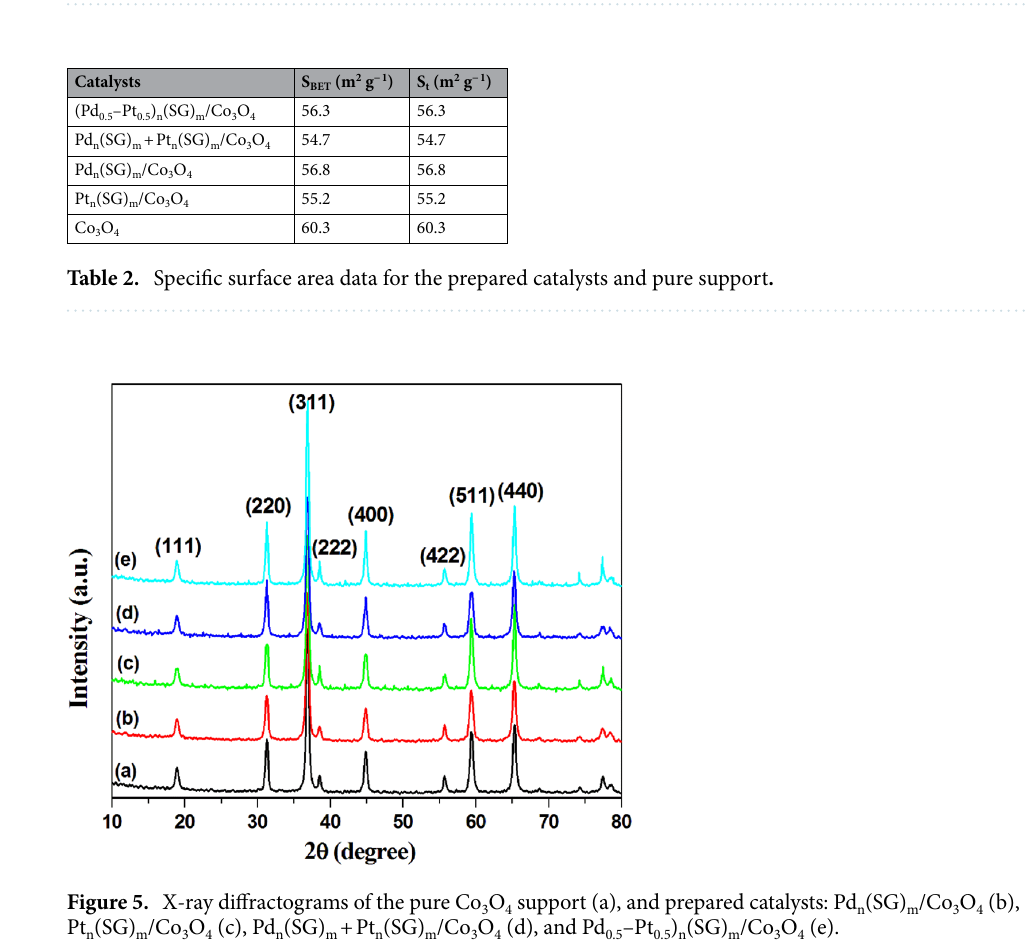
Figure 4. N 2 adsorption/desorption isotherms of the prepared catalysts and pure support show sorption isotherms type H3 according to the IUPAC classification.